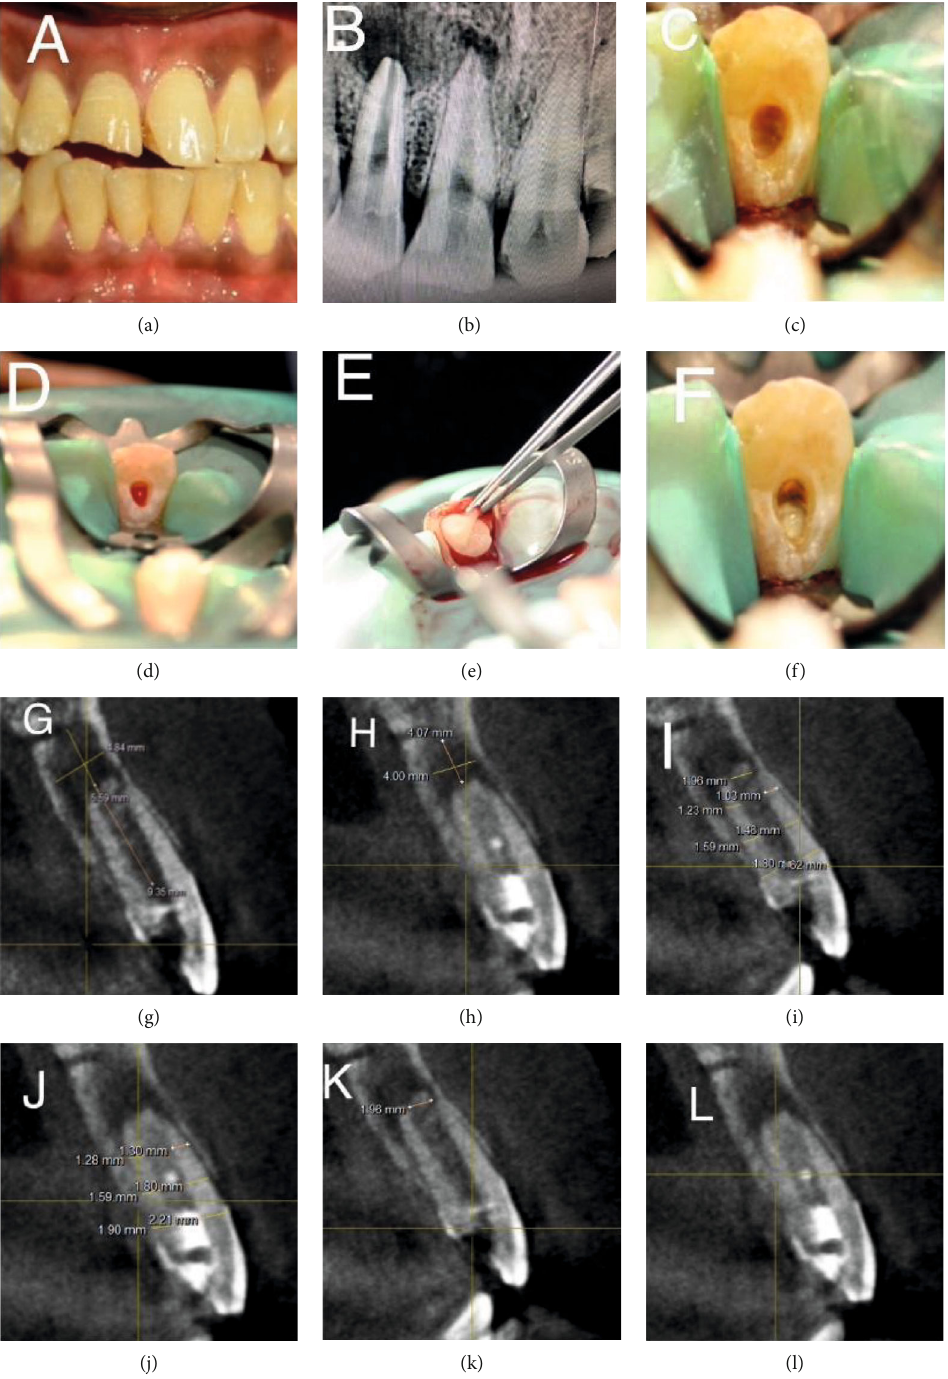
Figure 1: Preoperative clinical, revascularization procedure and radiographic images — IOPA and CBCT images (case report 1). (a) Pre-op clinical photograph showing fractured of 11 and 12. (b) Preoperative IOPA showing the periapical lesion involving the apices of 11 and 12 and immature roots of 12. (c) Access opening done in 12. (d) Bleeding induced in 12 for revascularization. (e) Placement of CGF in the root canal space. (f) MTA plug of 3 mm placed at the level of CEJ in 12. (g) Pre-op CBCT image showing the extent of lesion in sagittal slice. (h) Post-op CBCT image showing the extent of lesion in sagittal slice. (i) Pre-op CBCT showing the root dentin thickness measurement in sagittal slice. (j) Post-op CBCT showing the root dentin thickness measurement in sagittal slice. (k) Pre-op CBCT showing the apical diameter measurement in 12. (l) Post-op CBCT showing the apical diameter in